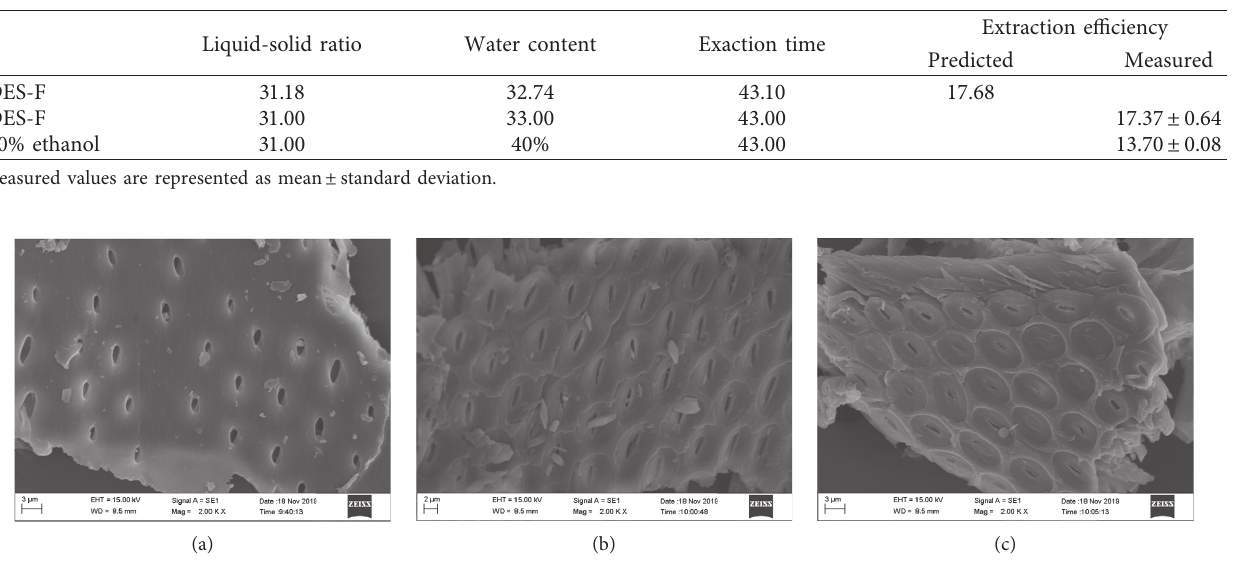
Figure 5: Scanning electron micrographs of Premna fulva Craib before (a) and after extraction with 40% ethanol (b) and DES-F (c).